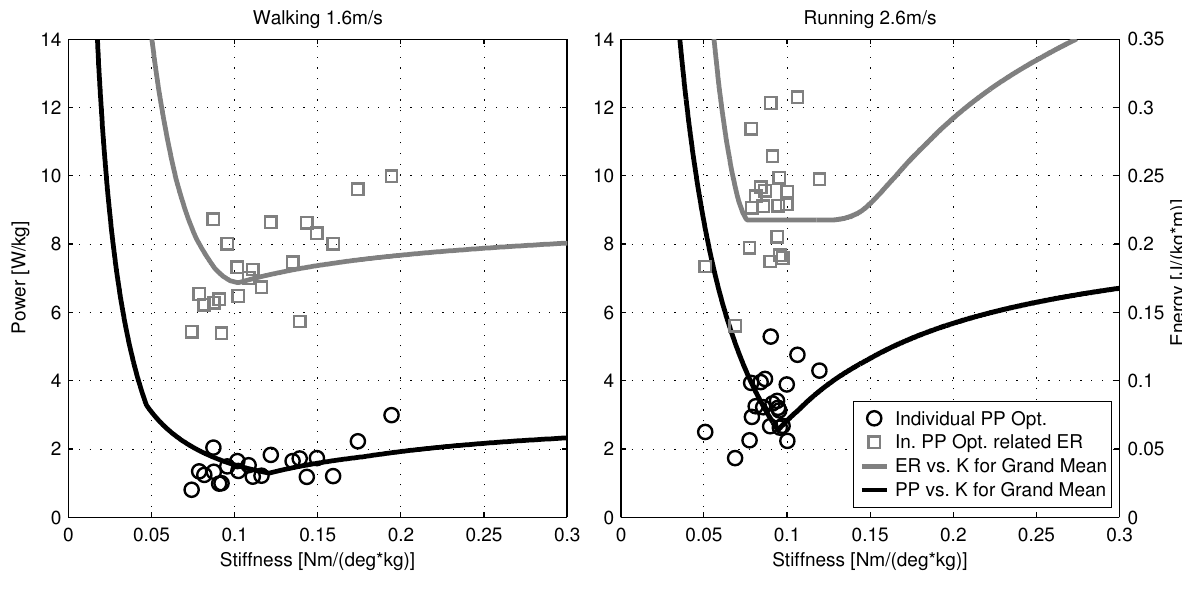
Figure 9. Peak power (black) and energy requirements (grey) in relation to spring stiffness K for walking at 1.6 m/s ( left ) and running at 2.6 m/s ( right ). The solid curves represent the values represent values for mean joint angle and mean joint torque as an input (21 subjects; grand mean). Single subject torque and angle curves were used to identify individual peak power optimum (small circles) and related stiffness. The corresponding individual energy requirement is indicated by a grey rectangle. In the worst case, peak power is more than two times the grand mean (231%), and the energy requirement is up to 145% of the grand mean.